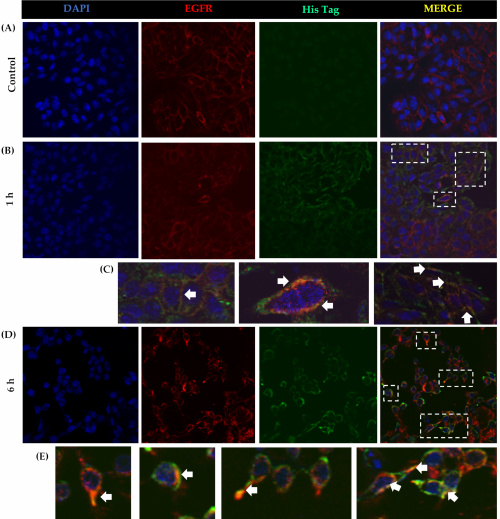
Figure 7. Colocalization of rTBL-1 and EGFR in SW-480 cell membrane. SW-480 cells were treated with rTBL-1 (61 µ g/mL) at 0, 1, and 6 h, followed by analysis by immunofluorescence and imag- ing by confocal microscopy at 40 × magnification. ( A , B , D ) Nuclei DAPI staining; Anti-EGFR and Anti-His were detected through Alexa 647 and Alexa 488, respectively. ( C , E ) Amplified sections of merge images (white dotted lines) and white arrows show colocalization rTBL-1-EGFR. Green color shows membrane-bound rTBL-1 not colocalized with EGFR. Representative images from at least two independent experiments.